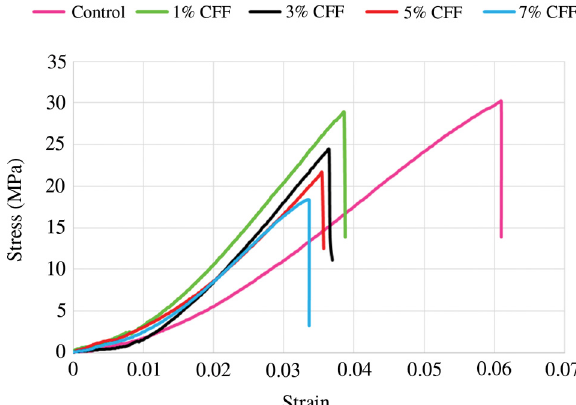
Figure 11: Stress-strain behavior of various compositions of CFF composite.